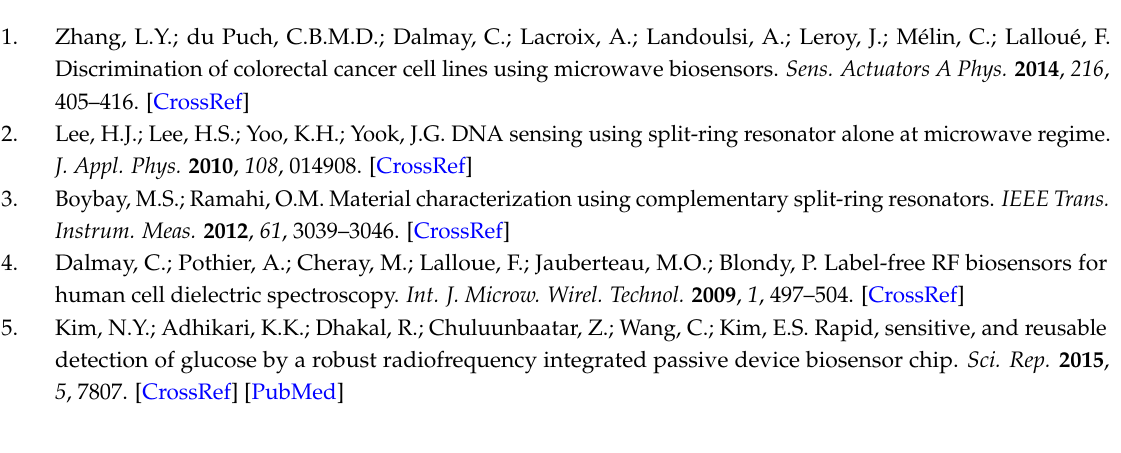
Figure S1: Microwave characterization of aqueous solutions using proposed microfabricated biochip. (a) Attenuation and (b) phase constant. Figure S2: Glucose-level-dependent impedance constituent parameters of the proposed biochip for human sera. (a) Net resistances and (b) net inductive